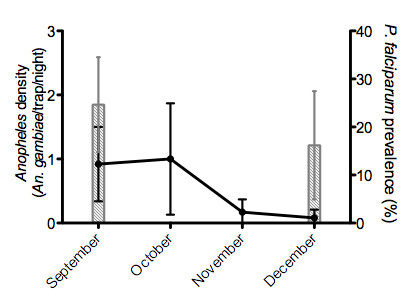
An. gambiae density and P. falciparum prevalence. Continuous line indicates the level of exposure to An. gambiae, calculated by the arithmetic mean (± SD) of the number of An. gambiae collected per trap per night from September to December in the six villages. In September and in December, the columns indicate the P. falciparum prevalence in all children (nSeptember = 403 and nDecember = 388) from studied villages.